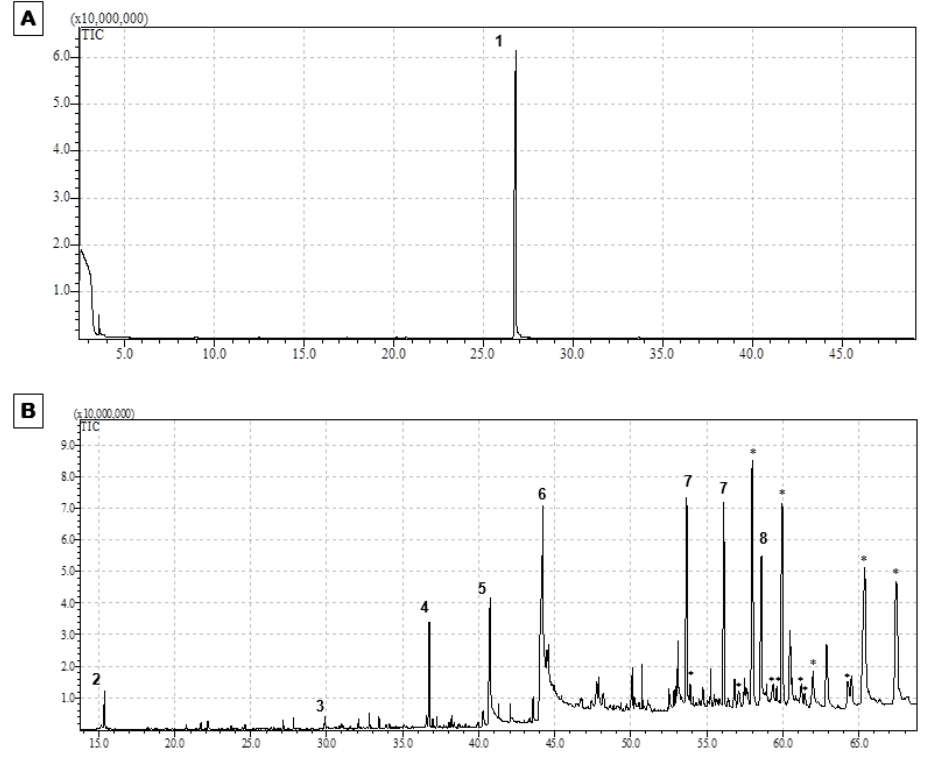
Figure 1. GC ‐ MS chromatographic profiles of potential bioactive compounds present in Brassicaceae extracts obtained by supercritical CO 2 extraction. ( A ) Chromatographic profile of watercress extract; ( B ) Chromatographic profile of broccoli extract; legend: (1) PEITC; (2) 3 ‐ Butenyl isothiocyanate; (3) β‐ PEITC; (4) SFN; (5) I ‐ (+) ‐ Ascorbic acid 2,6 ‐ dihexadecanoate; (6) Ethyl Linoleolate; (7) Tetracontane; (8)